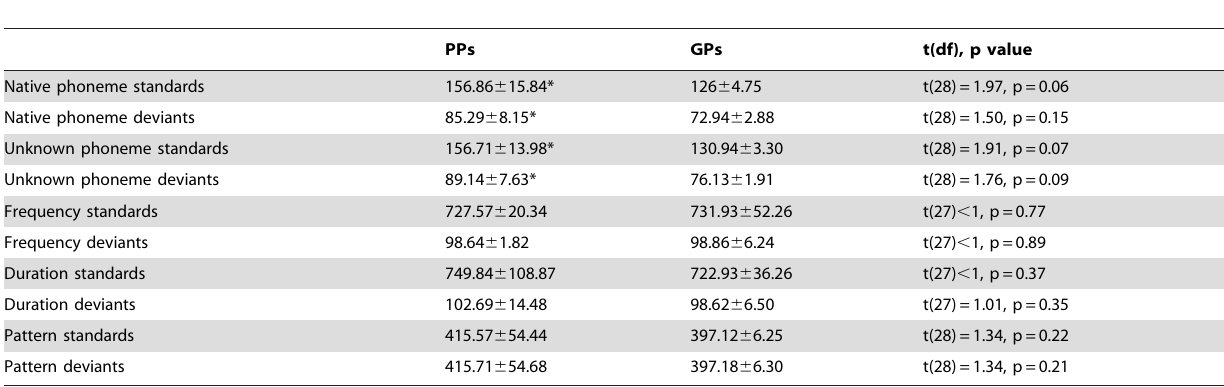
Table 1. Epoch numbers in the different conditions, for the GPs and PPs